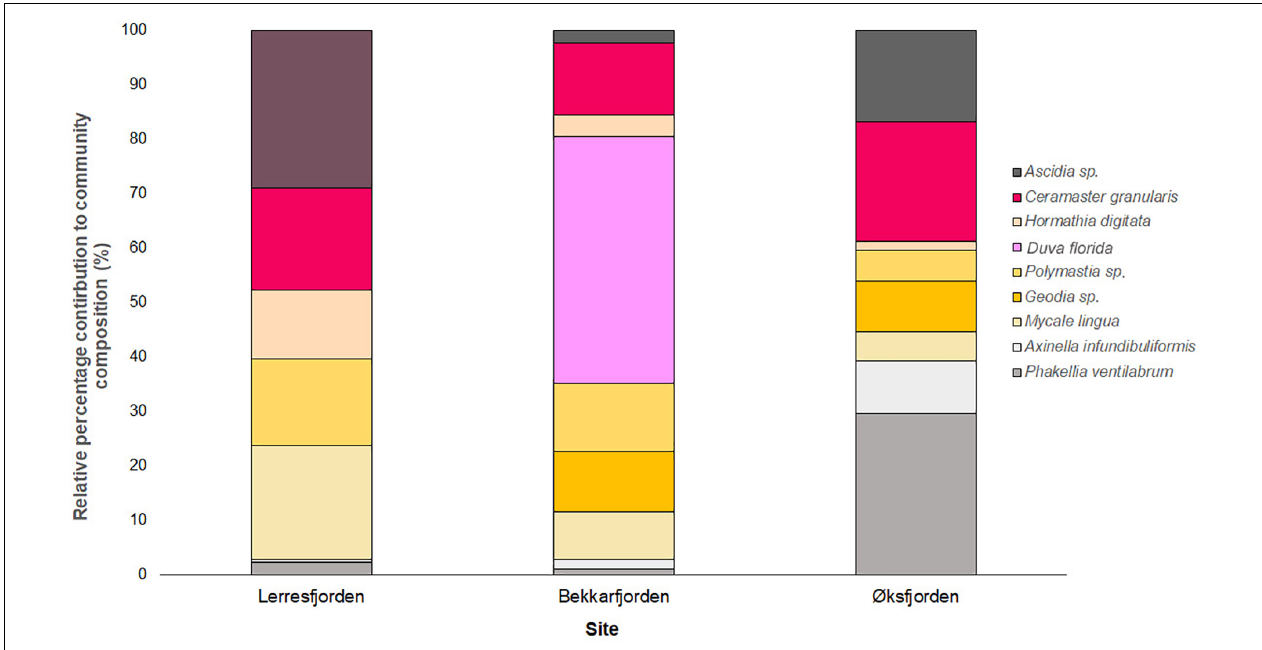
FIGURE 7 | Stacked bar chart of the relative percentage contribution of the 9 key epifaunal taxon to the community composition of the key epifaunal species at Lerresfjorden, Øksfjorden, and Bekkarfjorden. Bar charts show the median density of replicate transects at each fjord.